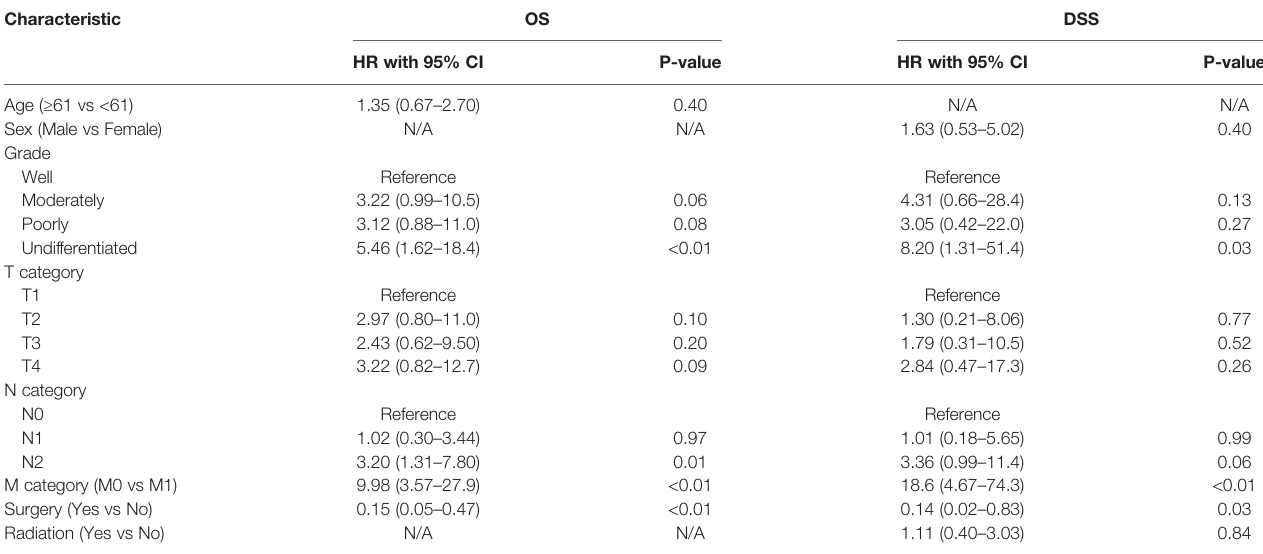
TABLE 3 | Multivariate COX regression analysis for OS and